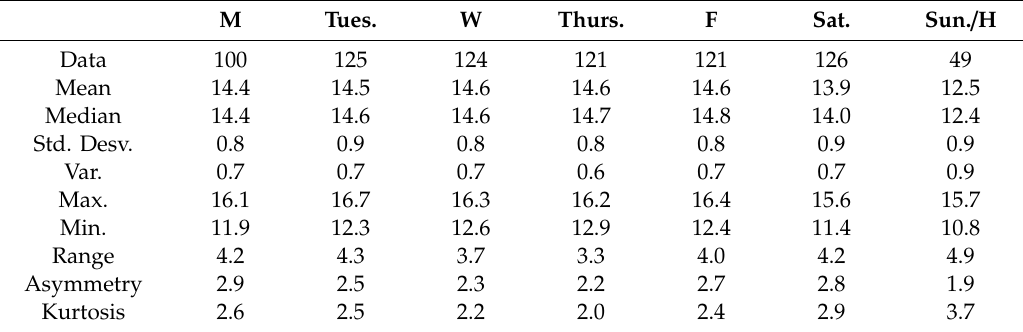
Table 1. Summary for the statistics of the daily energy demand series. M Tues. W